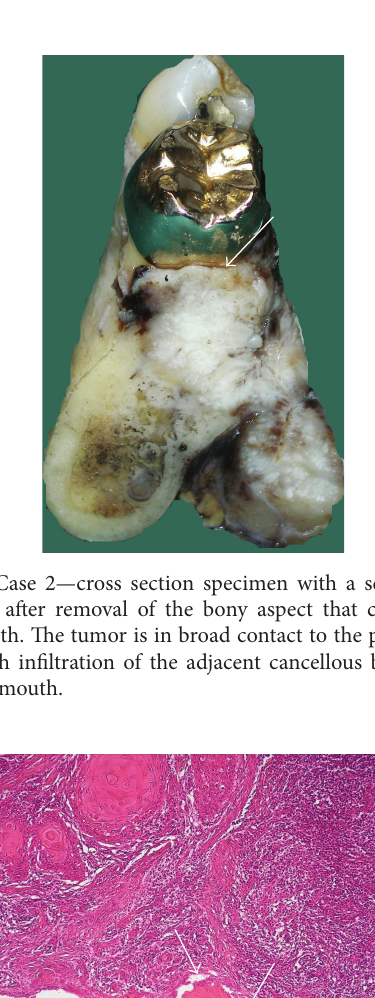
Figure 5: Case 2—Preoperative OPTG—A large formation of enhanced translucency is found in projection of the radices 36 and 37 as also at the pericoronal aspect of the partially retained wisdom tooth.